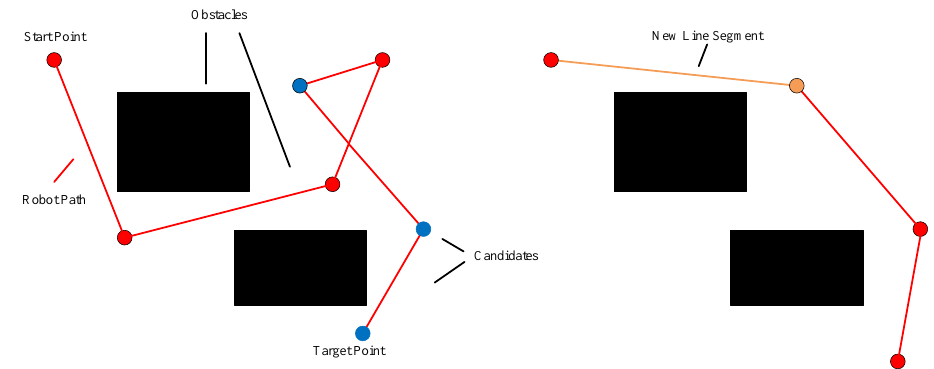
Figure 9. The shortest operator is presented. In the left sub-figure, blue circles indicate the sequentially selected candidate points. The resulting path is shown in the right sub-figure.